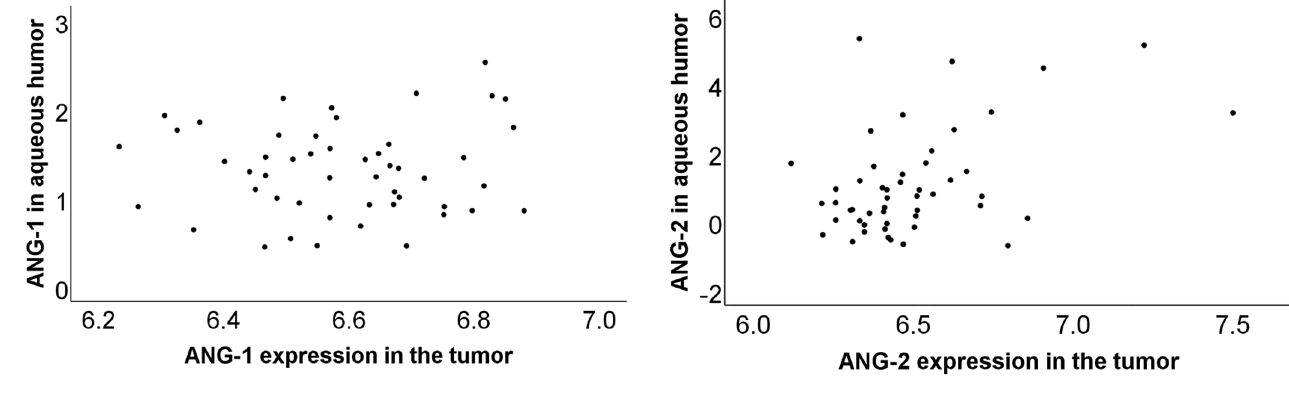
Figure 3. Two scatterplots to visualize the correlation between protein and gene expression of angiopoietins: ( A ) Correlation of ANG-1 protein and mRNA expression (rS = 0.02, p = 0.89). ( B ) Correlation of ANG-2 protein and mRNA expression (rS = 0.31, p = 0.03).